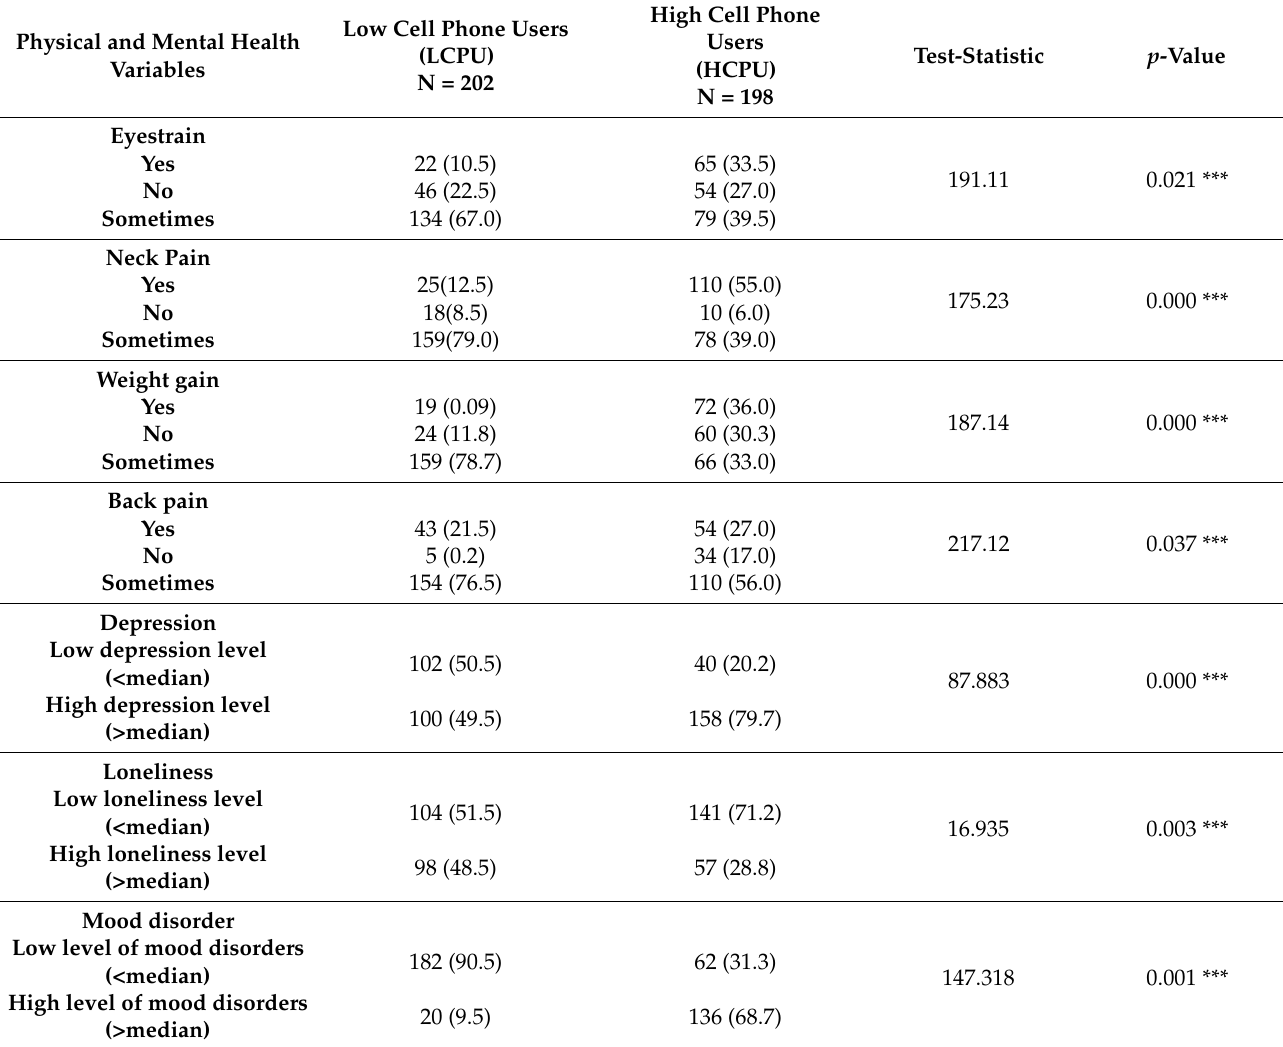
Table 2. Comparison of the proportions between two groups (LCPU and